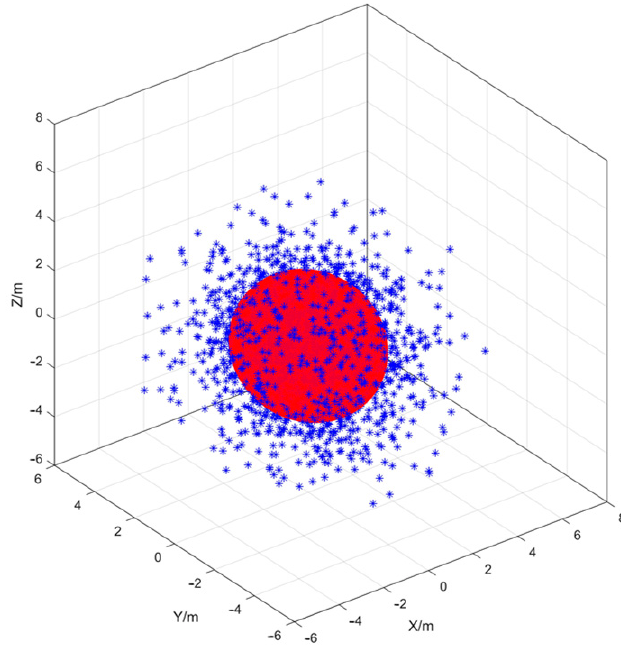
Figure 3. Spherical Error Probable.